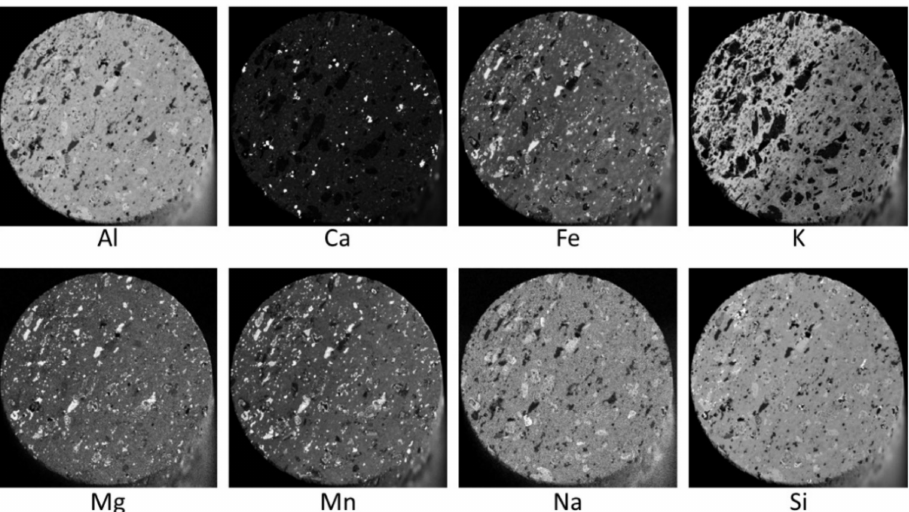
Figure 3. µ XRF elemental maps from the bottom surface of the training data shown with greyscale intensities indicating elemental concentrations. The raw elemental maps show noisy artefacts on the lower right portion of the image from the long edge of the cylindrical drill core, as the flat faces of the sample were not parallel. This results in detection of X-ray signals from the long edge of the cylindrical sample. This artefact was removed by masking with the corresponding µ CT image. The µ XRF elemental maps from all surfaces collected can be found in the Supplementary Materials.